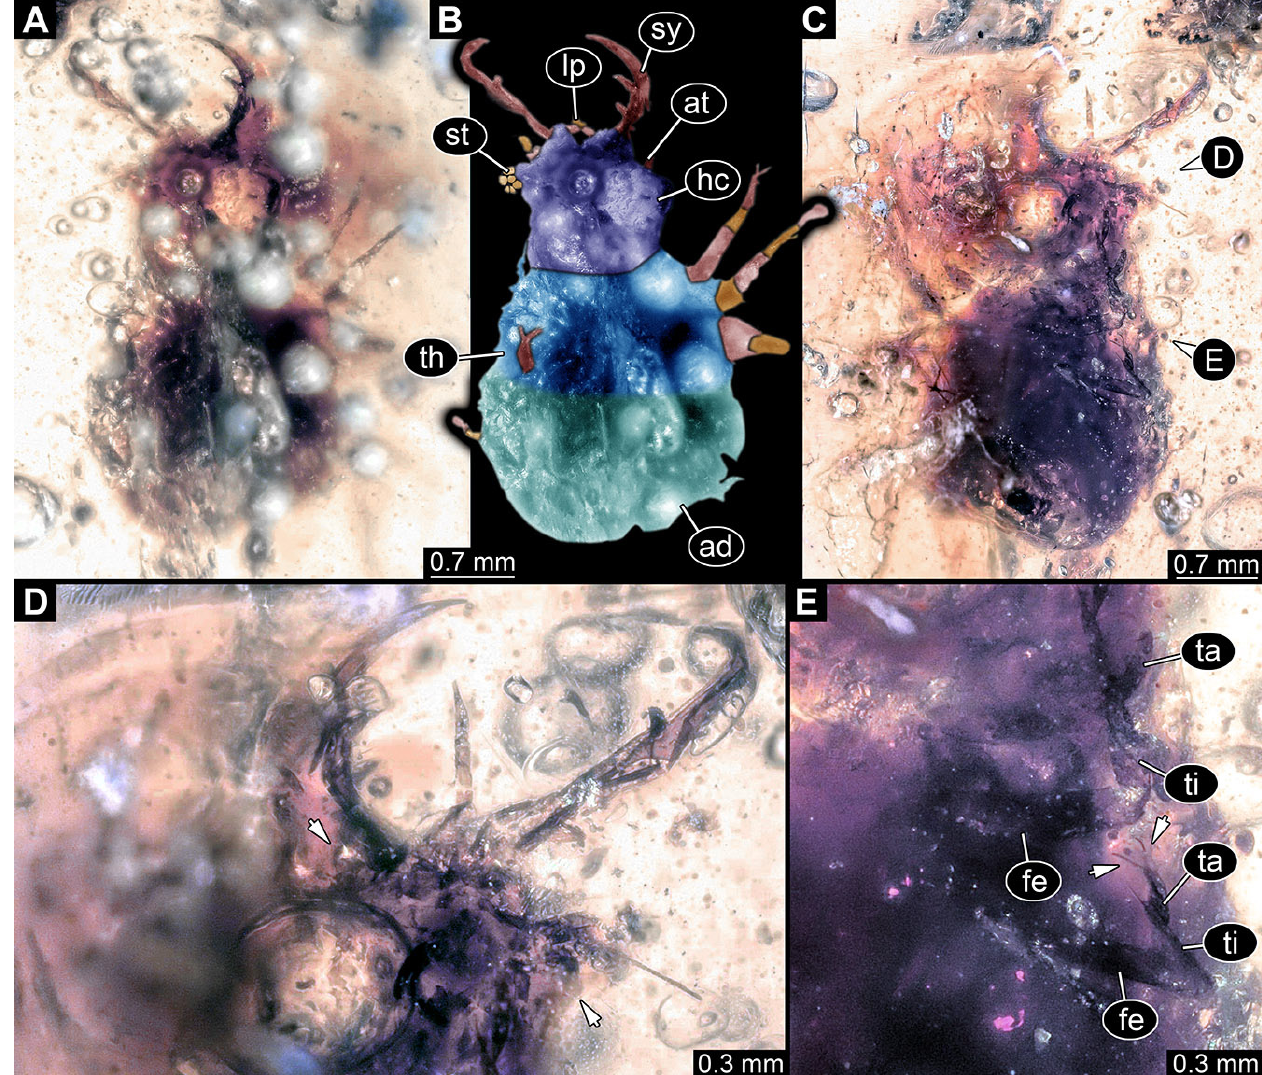
Figure 29. Fossil owllion larva, specimen 3242 (PED 0575), Cretaceous Kachin amber, Myanmar. ( A ) Overview, dorsal. ( B ) Color-marked version of ( A ). ( C ) Overview, ventral. ( D ) Close-up on head capsule with fields of stemmata (arrows). ( E ) Close-up on locomotory appendages with claws (arrows). Abbreviations: ad = abdomen; at = antenna; fe = femur; hc = head capsule; lp = labial palp; st = stemmata; sy = stylet; ta = tarsus; th = thorax; ti = tibia.